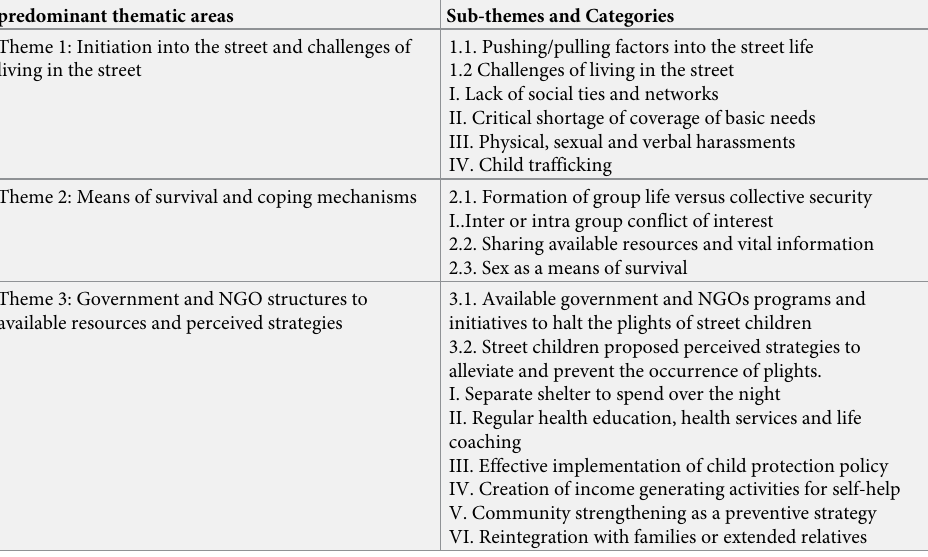
Table 2. Major thematic areas, sub- themes and categories of in-depth interviews and FGDs responses of street children in Ethiopia,